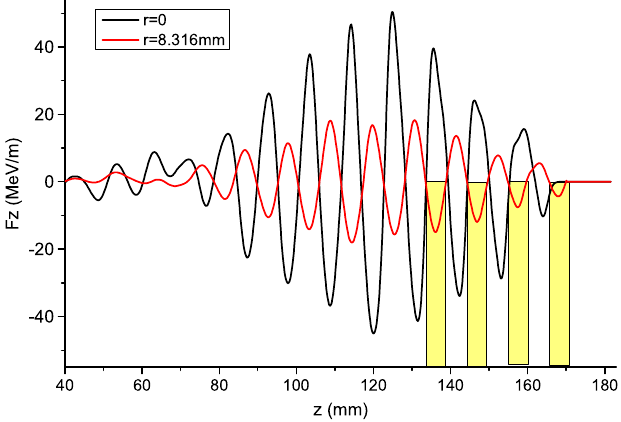
FIG. 3. Axial wakefields set up by four equally charged 50 nC, 14 MeV drive bunches.